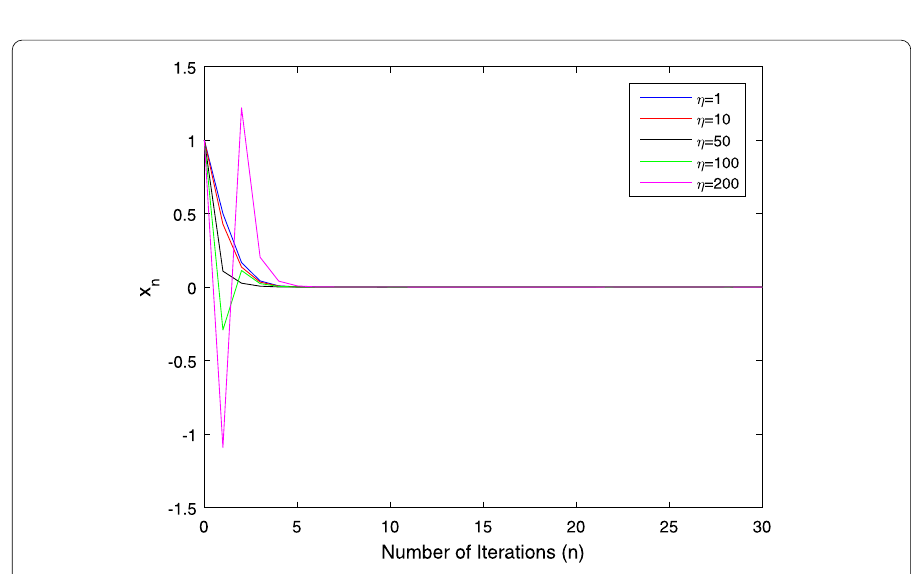
Figure 3 Behaviors of { x n } with different η = 1,10,50,100,200, x 1 = 1 and r = 4